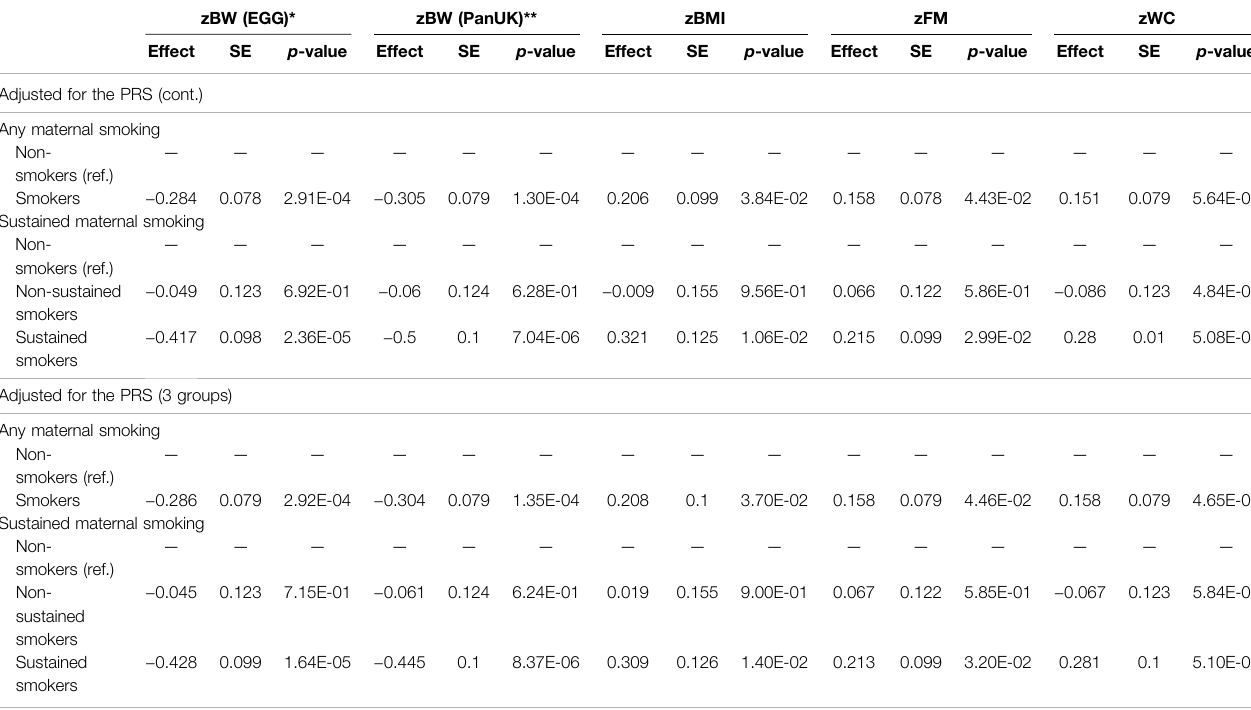
TABLE 2 | Association of maternal smoking during pregnancy with phenotypic traits, adjusted for the PRSs and covariates. zBW (EGG)*